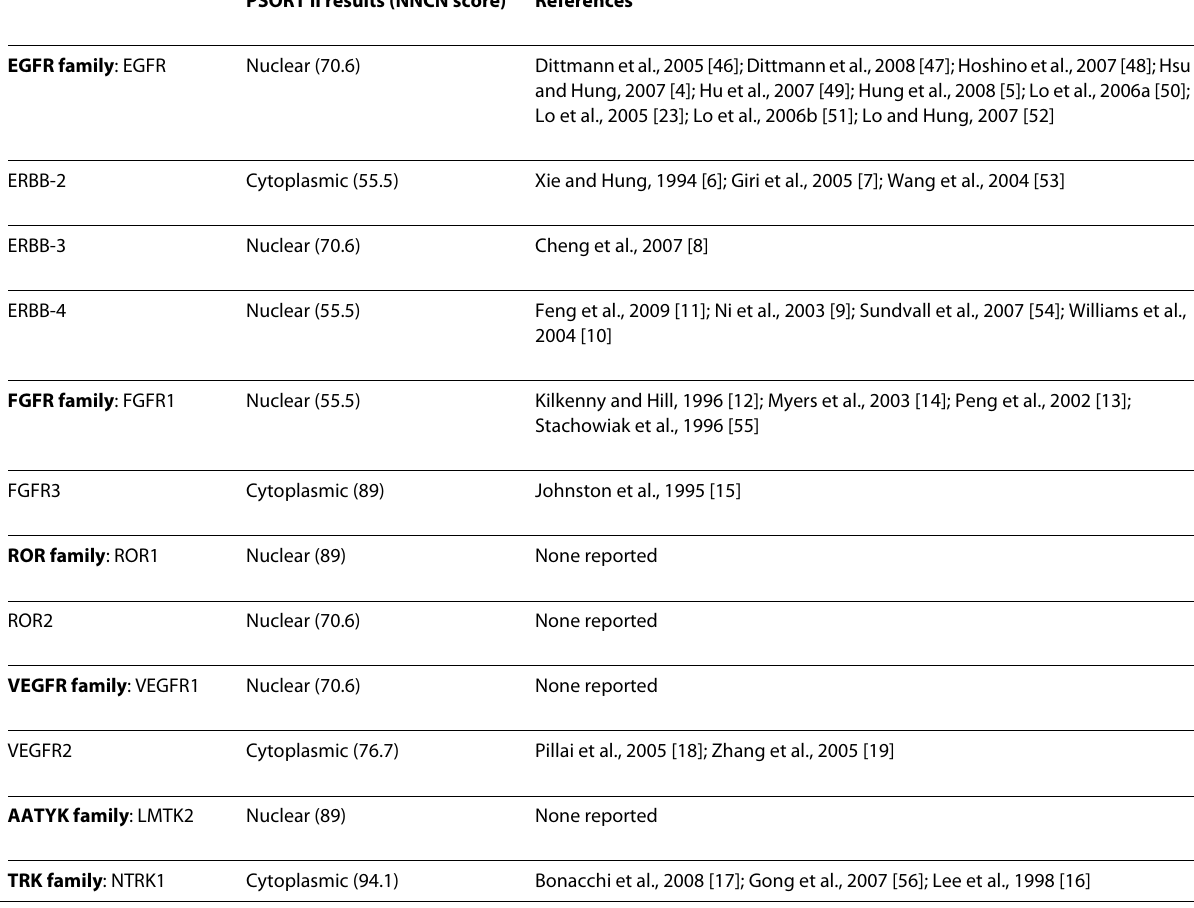
Table 1: Summary of nuclear-localized RTKs by PSORT II prediction PSORT II results (NNCN